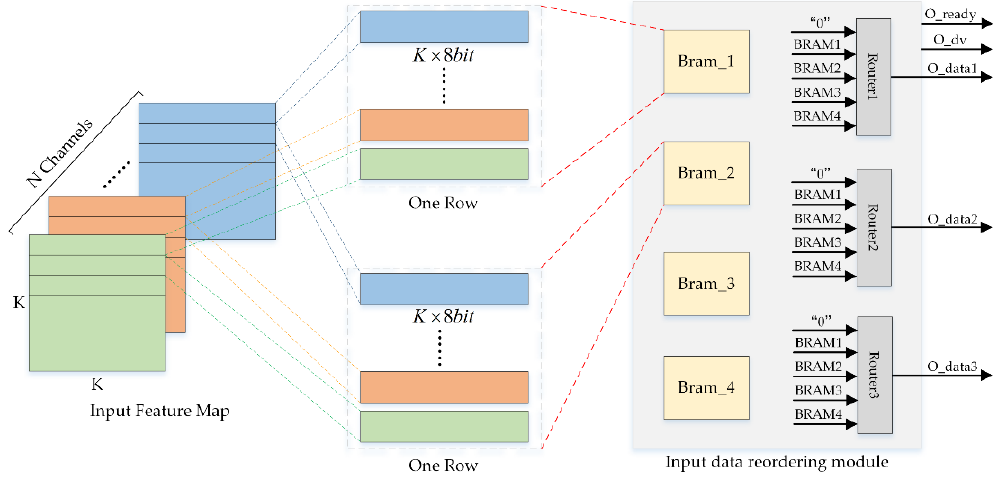
Figure 10. The diagram of the input data reordering module.